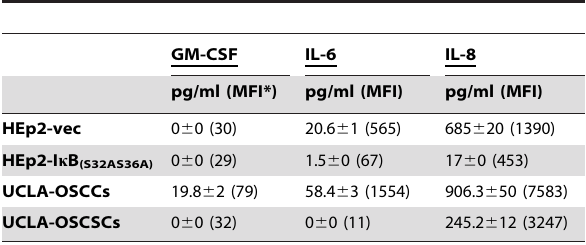
Table 1. UCLA-OSCSCs similar to HEp2-I k B (S32AS36A) tumor cells secreted no or lower levels of GM-CSF, IL-6 and IL-8.